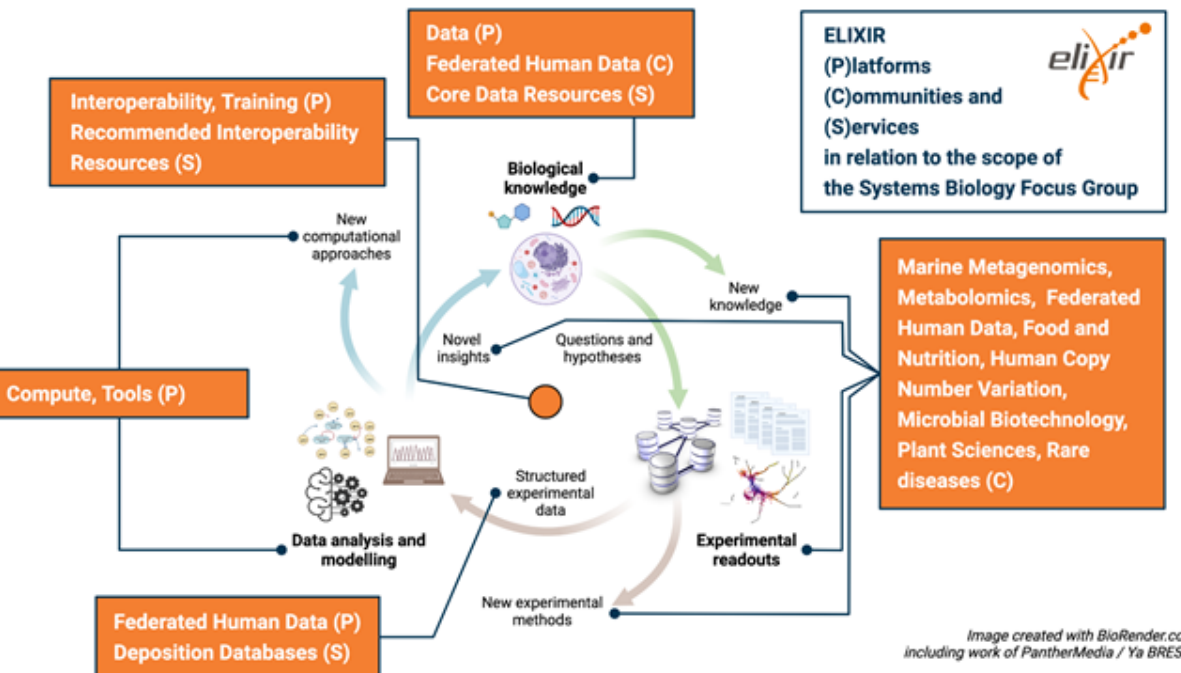
Figure 4. Schematic depiction of the systems biology “cycle”, mapped to ELIXIR Platforms, Communities and Services. This illustration shows the central role systems biology may play within the life sciences and how it links to and can supplement existing ELIXIR activities. The scheme spirals out of the plane of the paper in the sense that biological knowledge, experimental data, and models all increase in quality with each turn of the